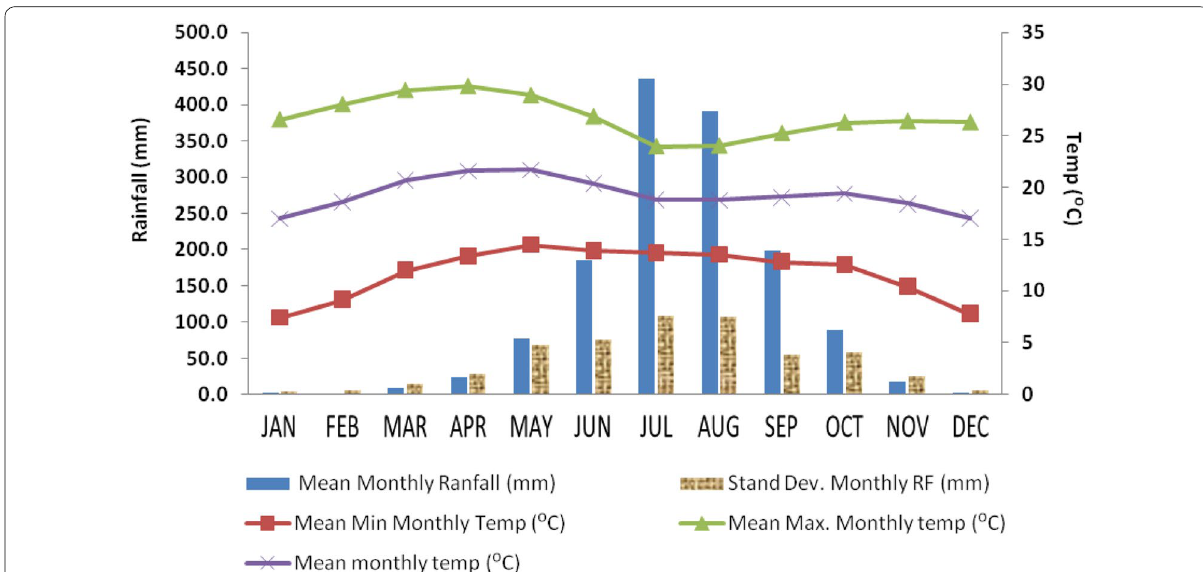
Fig. 2 Mean monthly rainfall and mean monthly temperature records of study area. It is based on the records of nearby Bahirdar station (1961– 2014) from National Meteorological service Agency, Ethiopia